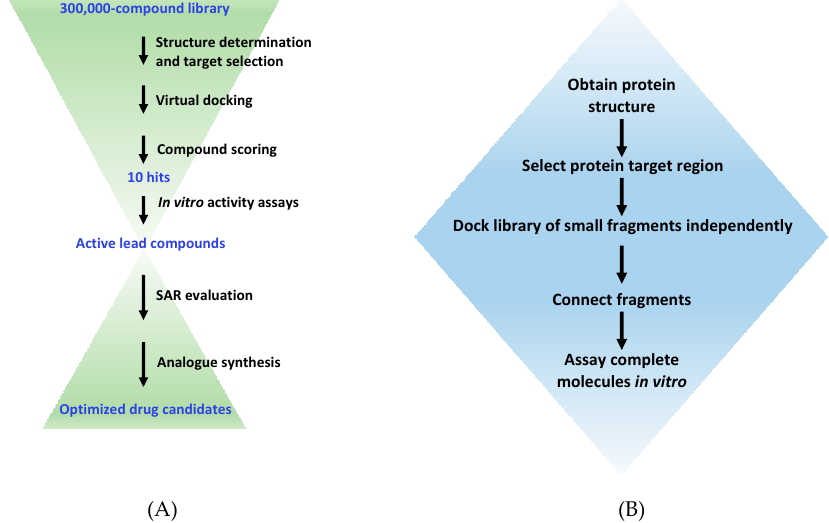
Figure 2. A typical workflow for virtual high-throughput screening and de novo drug design. ( A ) The virtual screening procedure used to select active compounds from a large library of existing molecules. SAR, structure-activity relationship. ( B ) The procedure for de novo design of ligands via the fragment-based approach using programs such as LUDI or SPROUT.